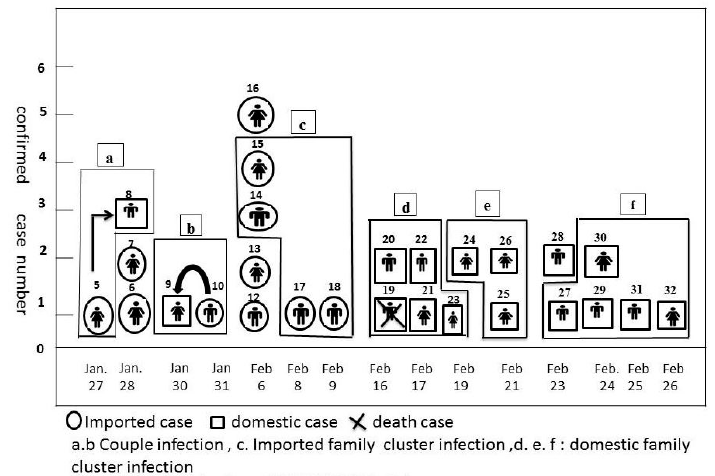
Figure 1. Family infections of severe acute respiratory syndrome coronavirus 2 (SARS-CoV-2) in